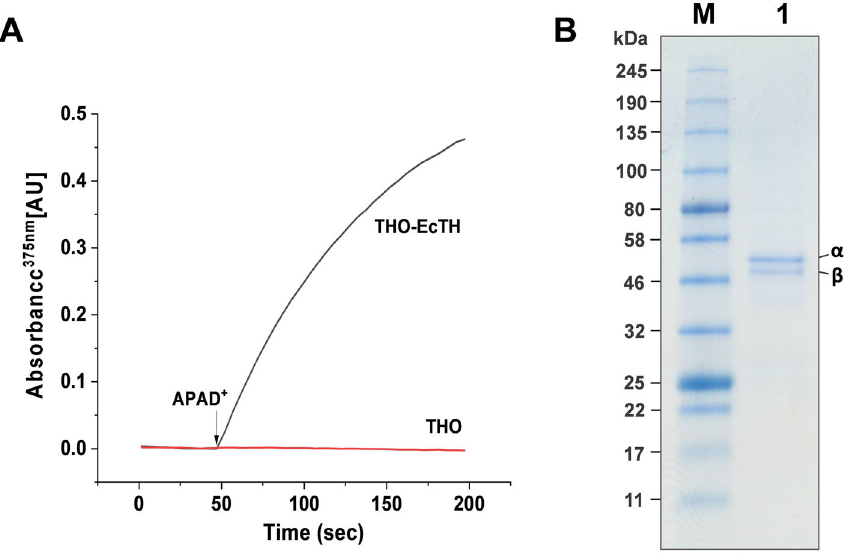
Figure 2. Overexpression and purification of E. coli transhydrogenase. ( A ) Reverse transhydrogenase activity of E. coli transhydrogenase in native membranes was measured spectrophotometrically by following the reduction of APAD + by NADPH at 375 nm. The reactions were carried out in 0.8 ml of 50 mM MOPS, pH 7.0 containing 100 mM KCl, 200 µM NADPH and 6 µM CCCP, and the reaction was started by adding 400 µM APAD + . The data were normalized to the total protein concentrations in the membranes. THO and THO-EcTH represent the membranes from THO and THO with E. coli transhydrogenase expressed from pET16b-EcTH, respectively. ( B ) The SDS-PAGE was conducted on 4–20% precast PAGE gel with Coomassie brilliant blue staining. Prestained protein marker, 11–245 kDa from New England BioLabs (lane M) was used. Approximately 1.2 μg of purified protein was loaded (lane 1). Subunits α (57.1 kDa with a Hexahis-tag) and β (48.7 kDa) are indicated. Graph created in Prism software (GraphPad, v7.0) and gel was labelled in Adobe Illustrator